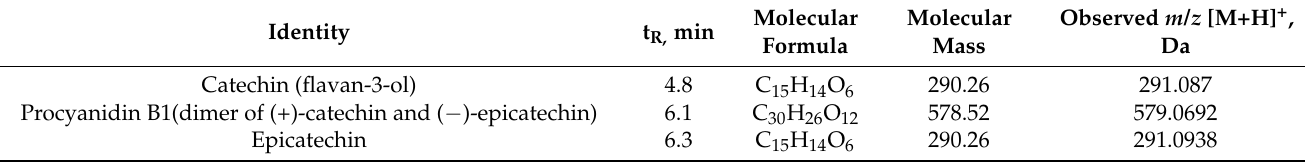
Table 2. Tentative identification of common compounds in methanolic (MeOH/H 2 O, 1:1) leaf and stem extracts of R. idaeus analyzed by